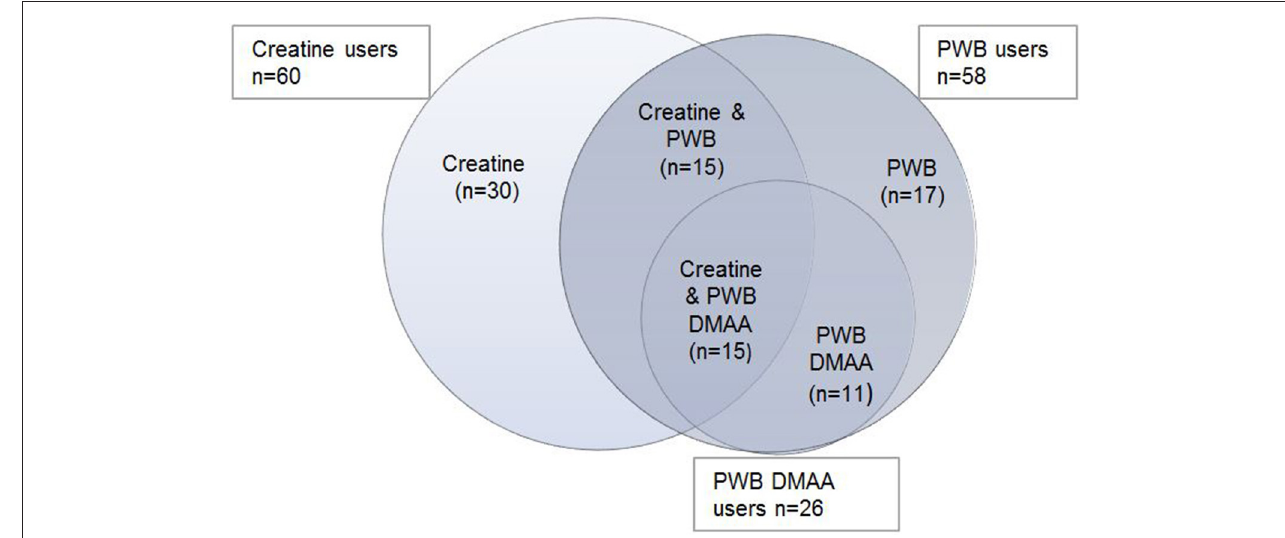
FIGURE 2 | Mixed last month consume of 60 creatine and 58 PWB